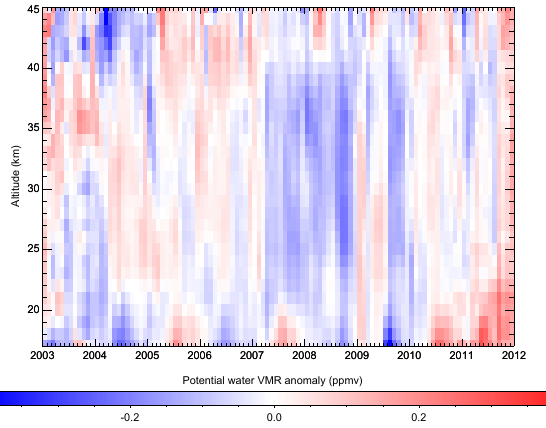
Figure 10. Potential water anomalies derived from combination of SCIAMACHY H 2 O and CH 4 anomalies (Fig.